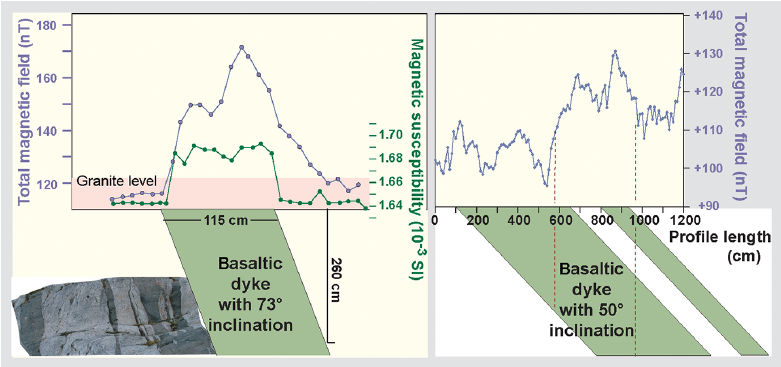
Figure 6. Magnetic effects of inclined dykes in perpendicular transects. (Left) Asymmetry of the D1 dykes, which is caused by its 70 ◦ inclination capturing a local signal up to 260cm depth. (Right) A 500cm wide dyke with an inclination of up to 50 ◦ integrating deeper signatures up to more than 500m